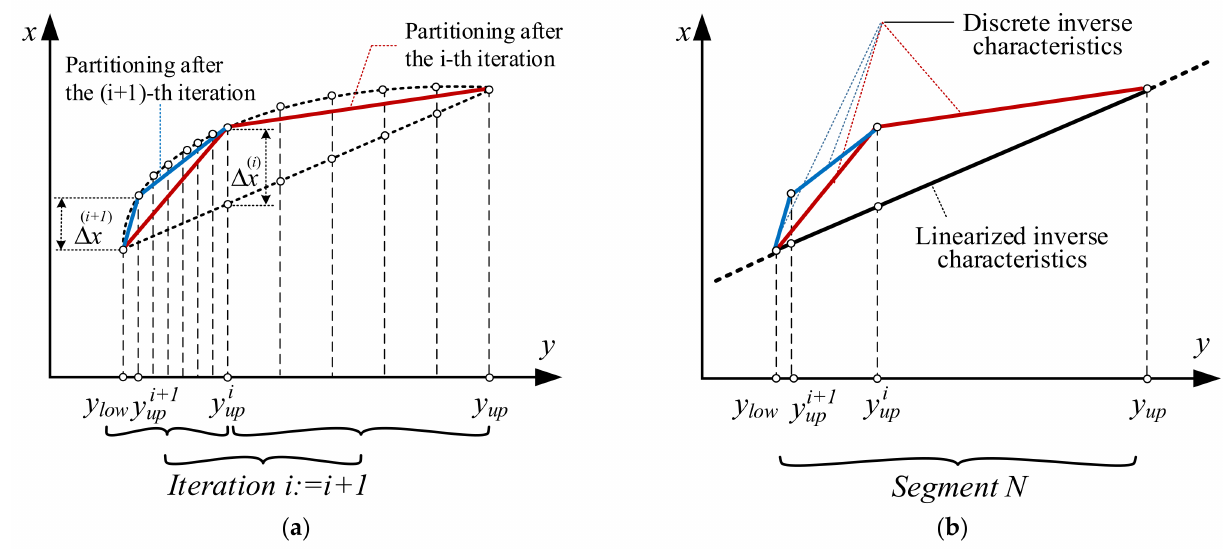
Figure 3. Graphical illustration of ( a ) the method in [11] and ( b ) the proposed